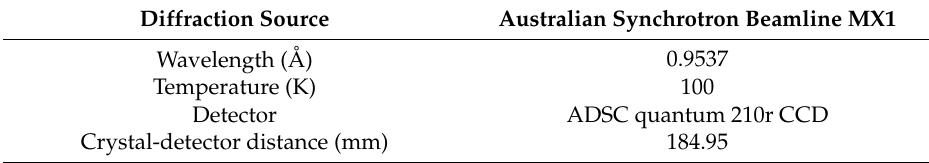
Table 3. Data collection and processing. Values for the outer shell are given in parentheses. All data were collected from a single